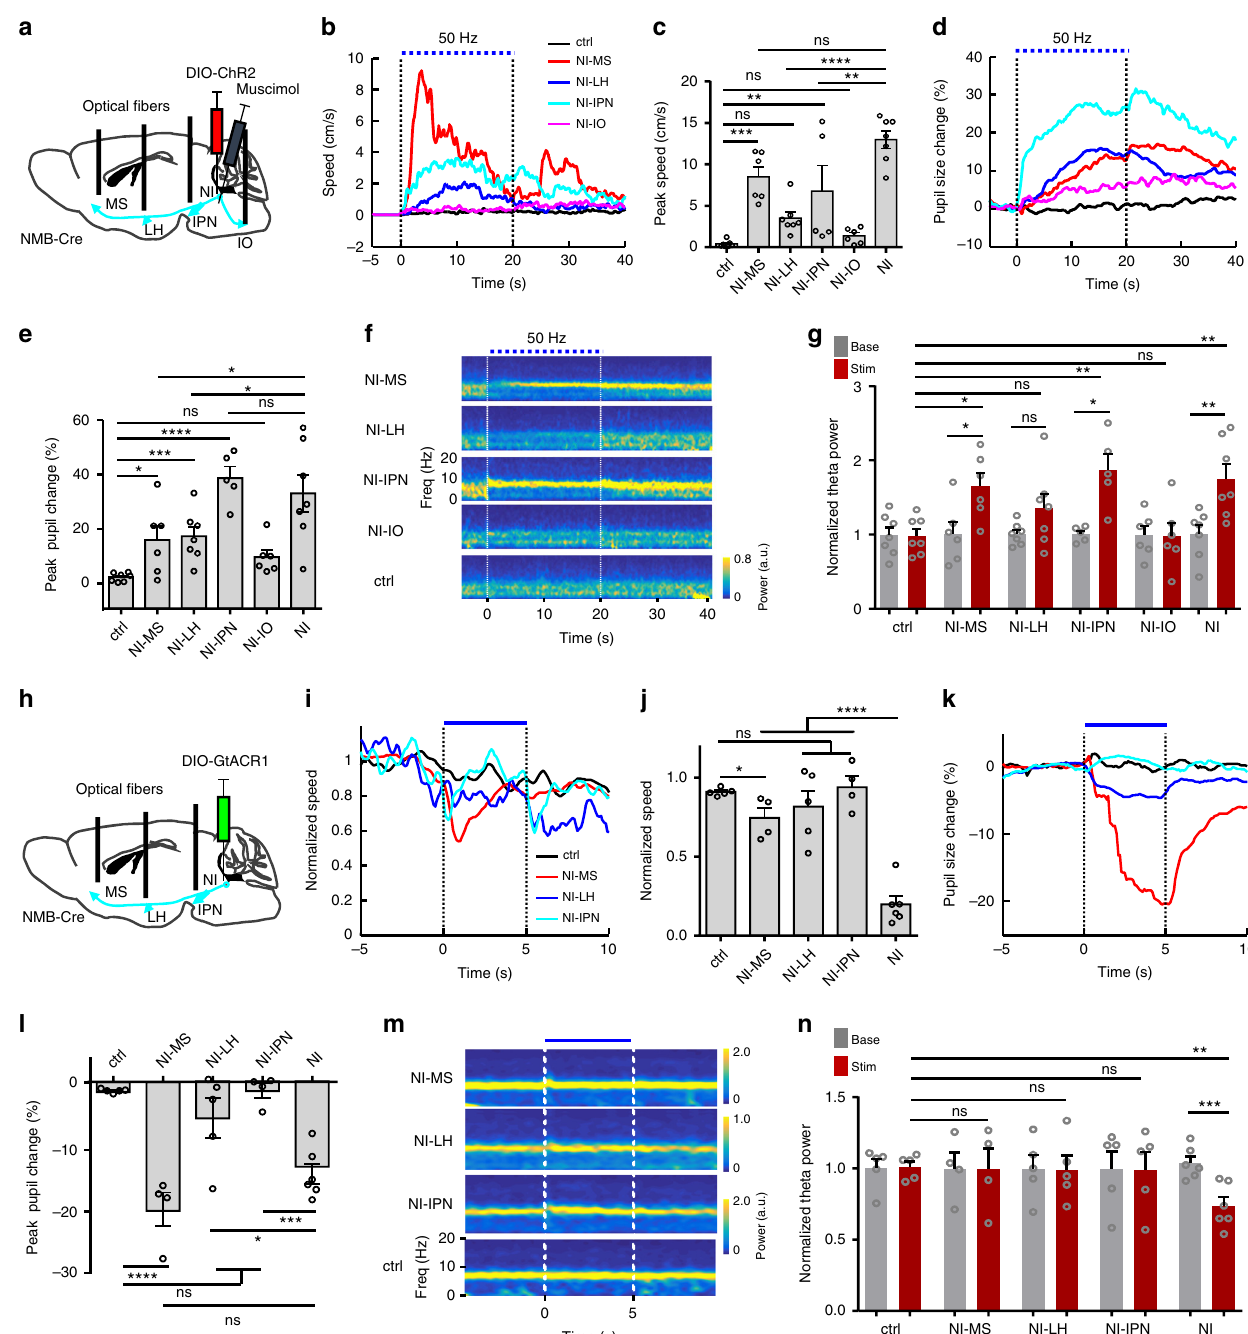
Fig. 7 NI-MS projections differentially modulates locomotion, arousal, and theta power. a Experimental schematic for viral expression of ChR2 and stimulation of NI terminals at different target regions. b, c Average traces ( b ) and summary data ( c ) showing the locomotor speed change evoked by terminal stimulation in the MS (red; n = 5 mice), the LH (blue; n = 7 mice), the IPN (cyan; n = 5 mice), and the IO (magenta; n = 6 mice) as well as stimulation of soma area in the NI ( n = 7 mice). Dashed blue line marks the duration of laser stimulation. d, e Average traces ( d ) and summary data ( e ) showing the change in normalized pupil diameter elicited by stimulating different projections and NI somata. f, g Grand average of LFP spectrograms ( f ) and summary data of theta power change ( g ) elicited by terminal stimulations in different target regions and the NI soma area (theta power is normalized to its base in each group). h Experimental schematic for viral expression of GtACR1 and optogenetic inhibition of NI terminals in various target regions. i, j Average normalized locomotor speed traces ( i ) and summary data showing the effect of optogenetically inhibiting axonal terminals in the MS (red; n = 4 mice), LH (blue; n = 5 mice), and IPN (cyan; n = 4 mice). Blue horizontal line and dashed vertical lines marks the duration of light inhibition. k, l Average traces ( k ) and summary data showing the effect of terminal inhibition and soma inhibition on pupil diameter. m, n Grand average of LFP spectrograms and summary of theta power change within different target regions and the NI soma area. The data for soma activation and inhibition in this Figure are identical to those presented in Figs. 2 and 3 for comparison purpose. Error bars ( c , e , g , j , l , n ) indicate SEM. * P < 0.05, ** P < 0.01, *** P < 0.001, **** P < 0.0001; ns, not signi fi cant; Dunnett ’ s multiple comparisons test; see Supplemental Table 1 for detailed statistical analysis. Source data are provided as a Source Data fi